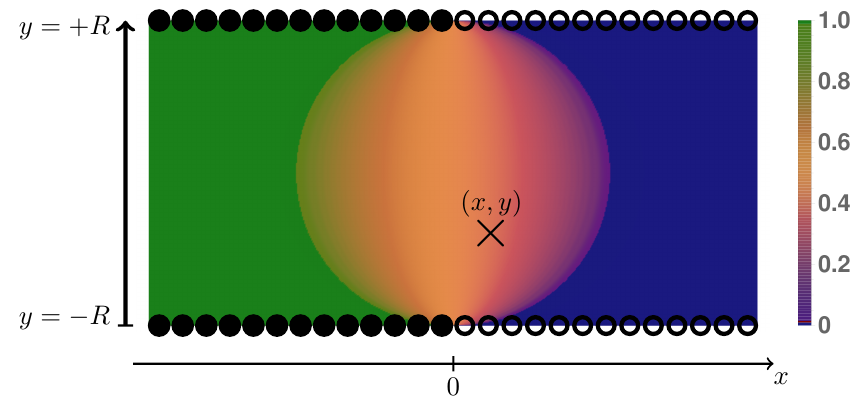
Figure 2: Imaginary time density profile corresponding to the quench from a semi-infinite box packed with fermions (filled black circles on the picture, the holes are shown with empty circles). The density at coordinate ( x , y ) is defined as (25). Green colors correspond to a density close to one, blue to a density close to zero. In both cases the system is said to be “frozen”: observables do not fluctuate at all. Intermediate colors correspond to finite densities, and have non trivial fluctuations. The fluctuating region is a disk of radius R , with density given by